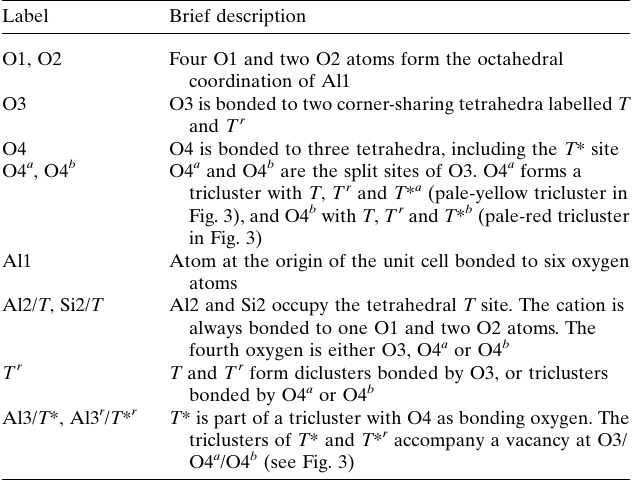
Table 2 Brief description of atom sites and selected symmetrically related